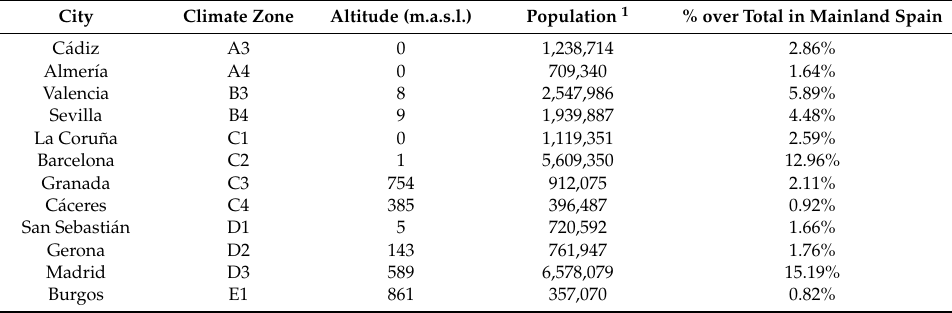
Table 2. Characteristics of the cities object of the study [37].